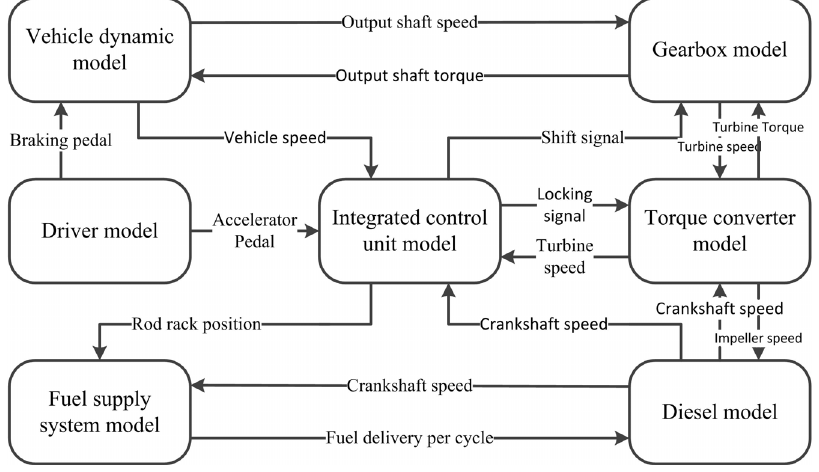
Figure 3. Real-time model